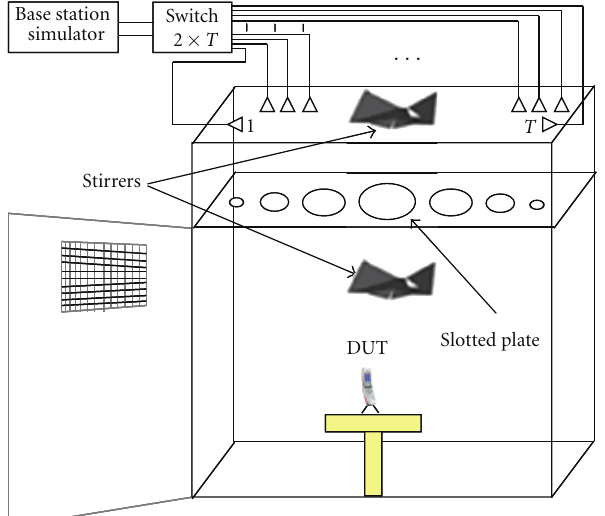
Figure 7: Reverberation chambers with multiple cavities (TR 37.976 [7] Figure 6 . 3 . 2 . 1-2).